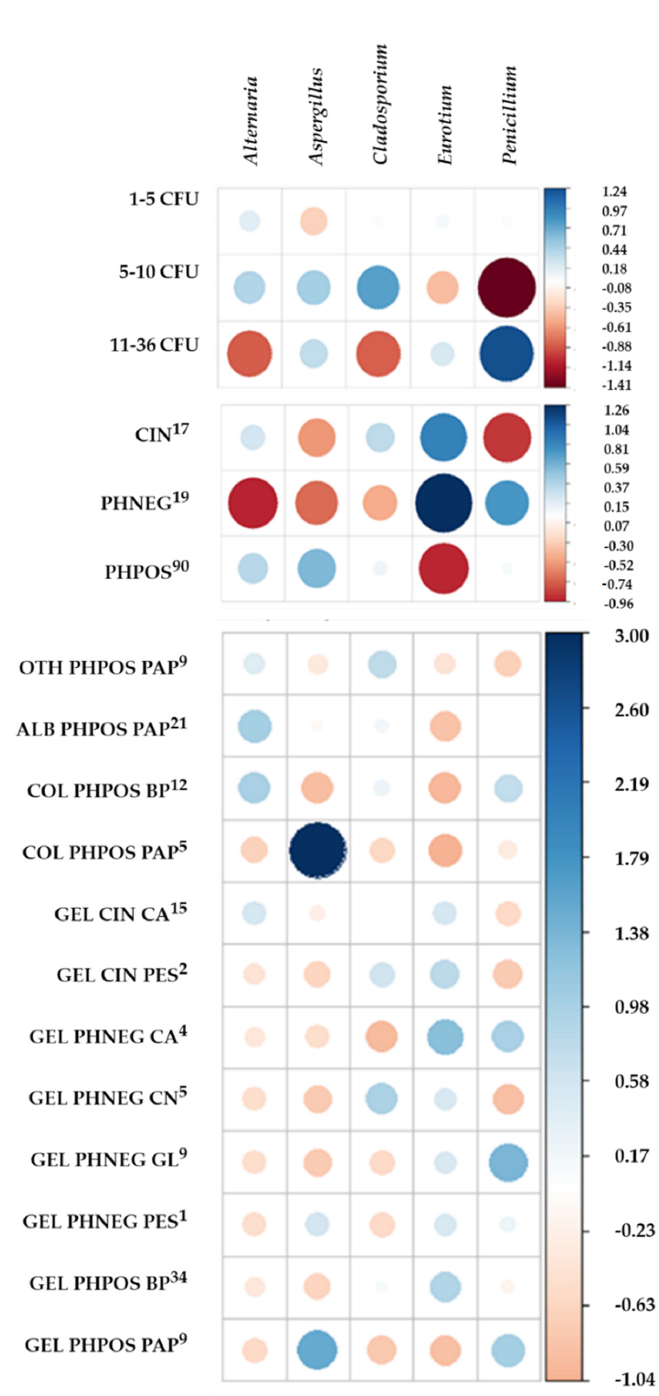
Figure 2. The standardized Pearson residuals for positive (blue) and negative (red) associations of the five most frequent fungal genera with analysed factors. These associations are between the fungal genus and the number of its CFU isolated from a sample, its isolation from single kinds of material (CIN, PHNEG, PHPOS) and the combination of the sample type and the materials of the light-sensitive layer and carrier. The size of the circle is proportional to the degree of cell contribution. The upper index indicates the number of analysed samples. Legend: CIN—cinematographic material,